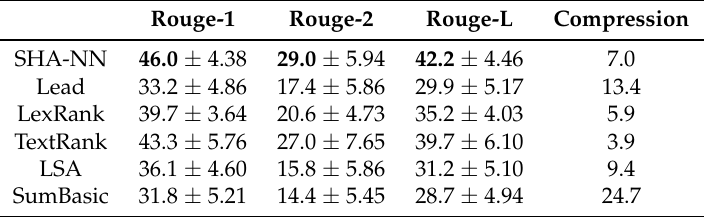
Table 4. Results on LN24-SUMM corpus with respect to the ground truth (full length Rouge F 1